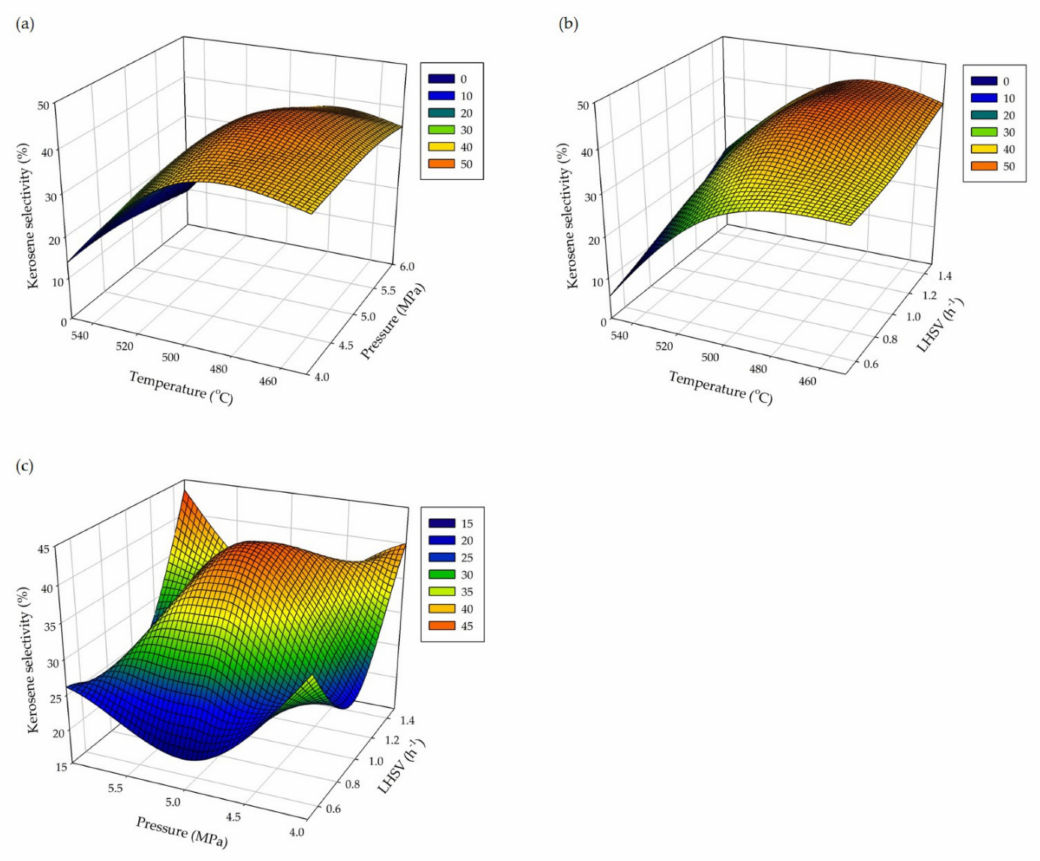
Figure 6. Response surface plots showing the e ff ects of ( a ) temperature and pressure, ( b )